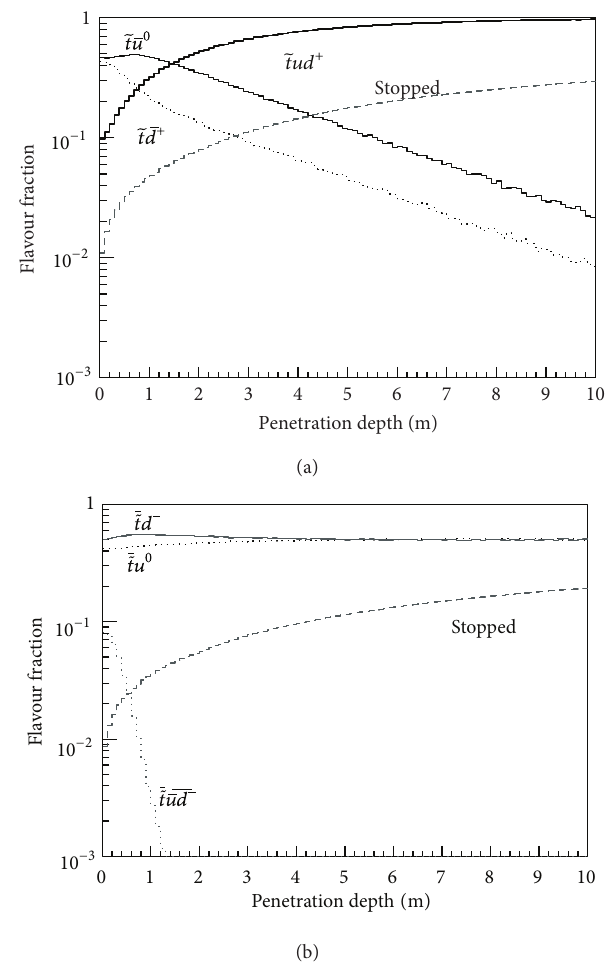
Figure 8: Flavor decomposition of heavy hadrons as a function of penetration depth in iron. The figures are for hadrons with stable scalar top and anti-top quarks, but the results are identical if ̃𝑡/̃𝑡 is replaced by stable fourth-generation 𝑈/𝑈 quarks. For the figure, a stop mass of 300GeV was used. Figure from